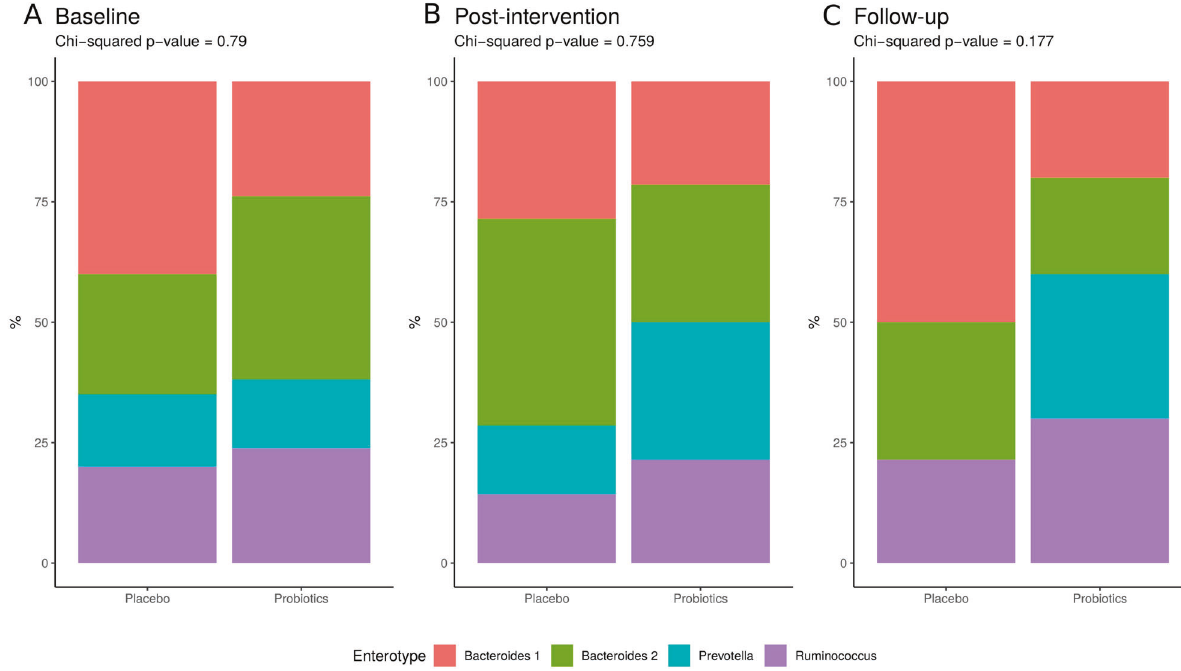
Fig. 2 Enterotype distribution within time points. Group differences at baseline ( A ), post-intervention ( B ), and follow-up ( C ) per study groups.